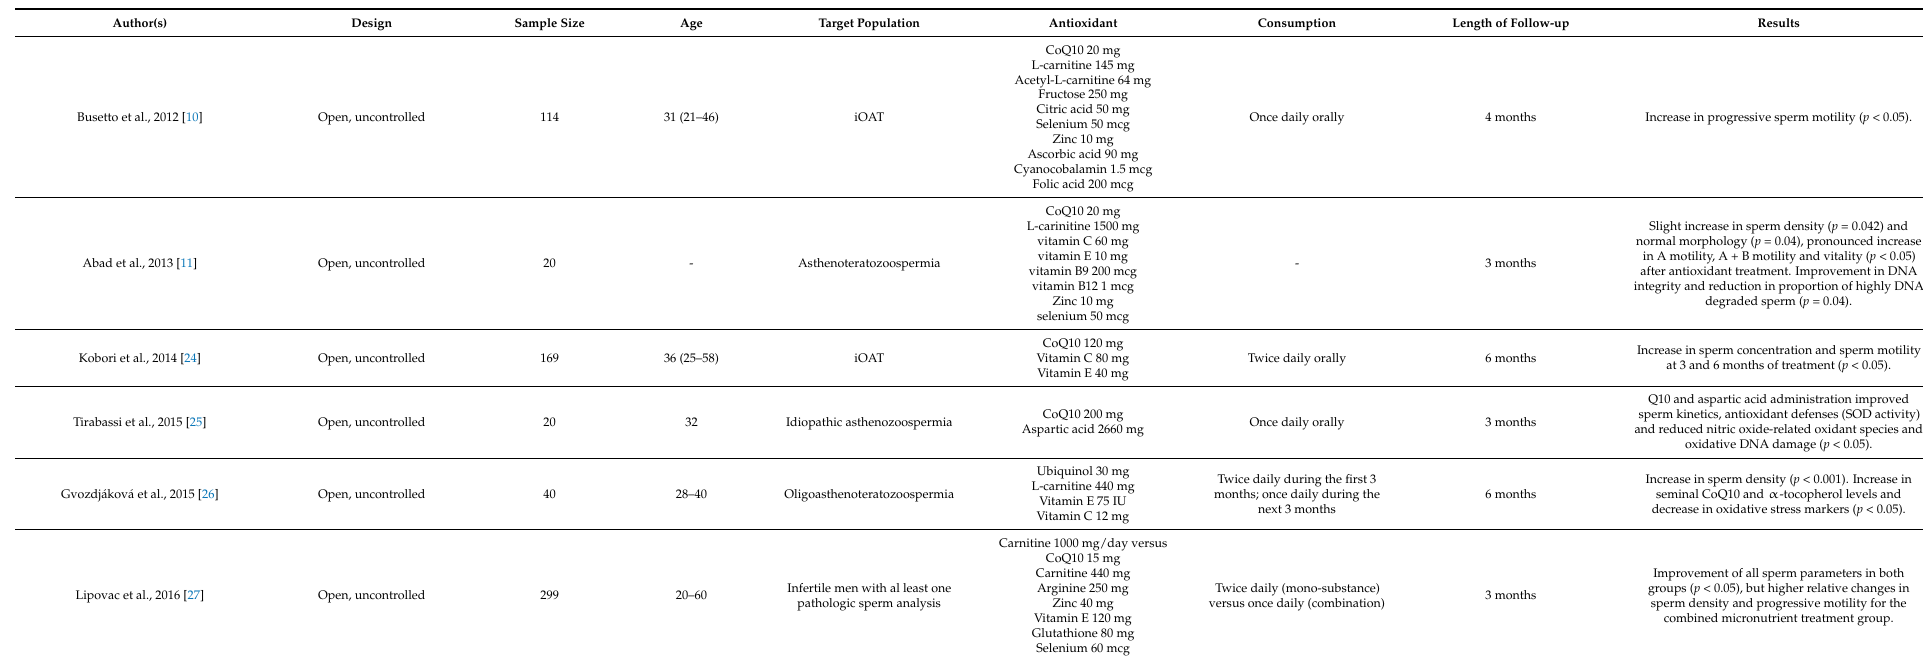
Table 2. Coenzyme Q10 and male fertility (mixed compounds), characteristics of suitable